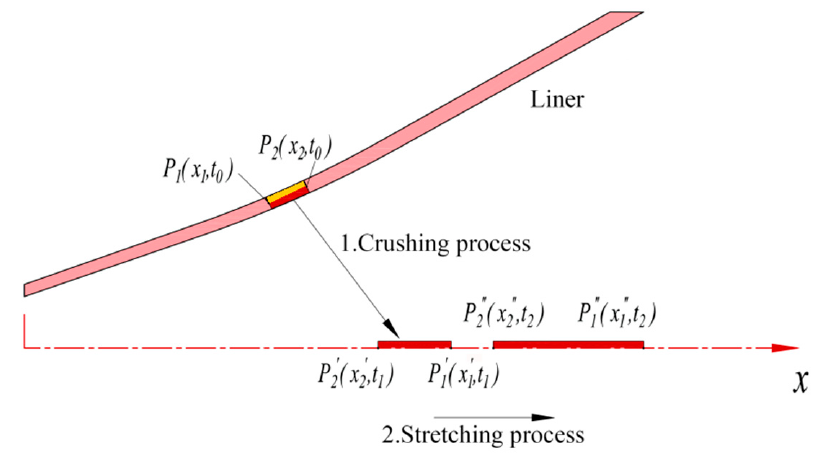
Figure 1. Schematic of the collapse and stretching of a jet element.